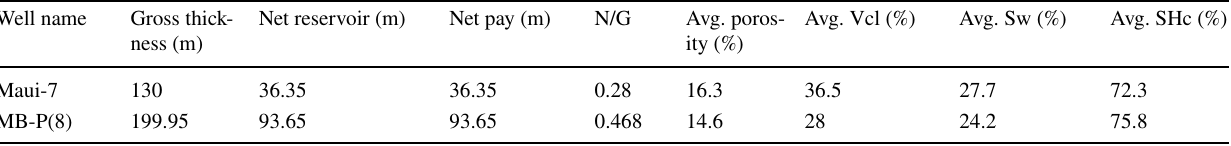
Table 1 Well log petrophysical parameters of the Kaimiro Formation